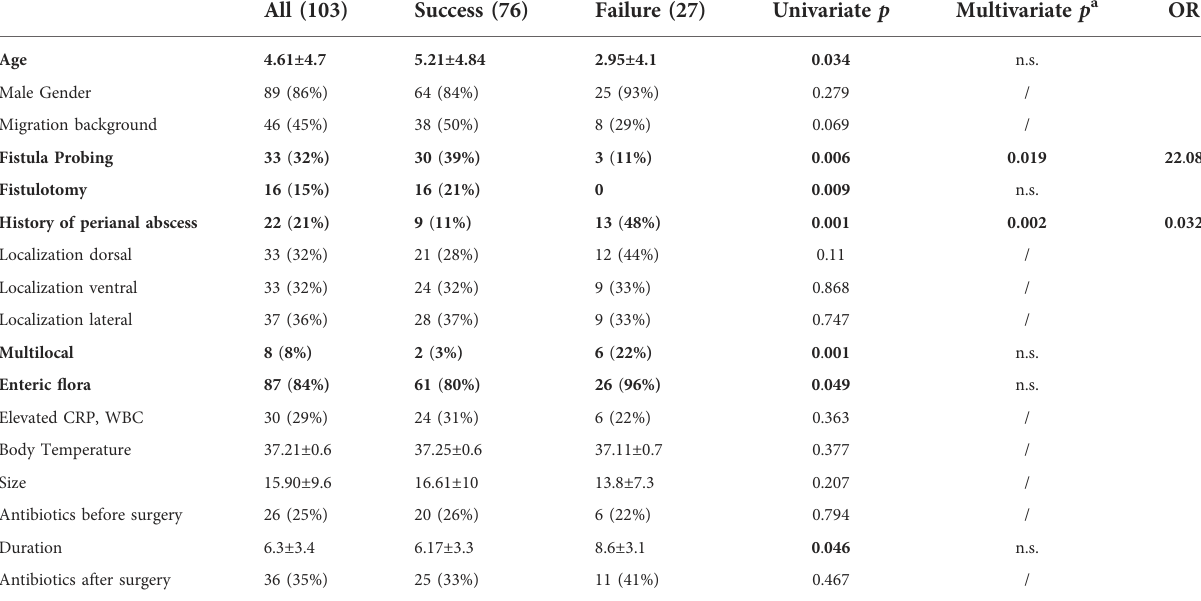
TABLE 1 Patient and disease characteristics related to success and failure of surgical treatment.